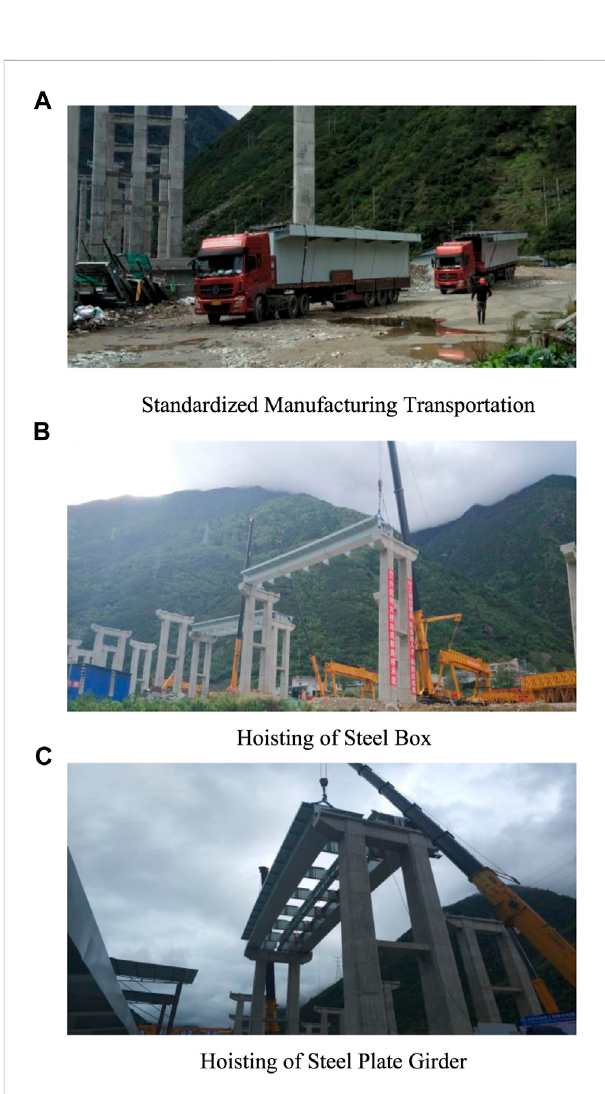
Transportation and Hoisting Construction of Steel box-Steel plate Composite